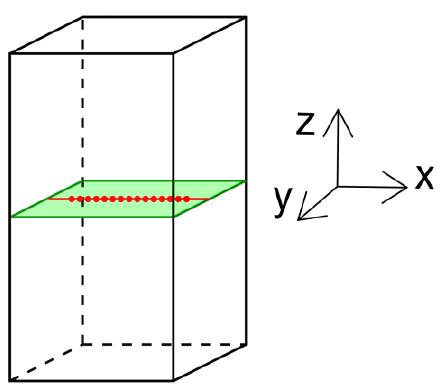
Fig. 2. Test section with with a highlighted cross-section .